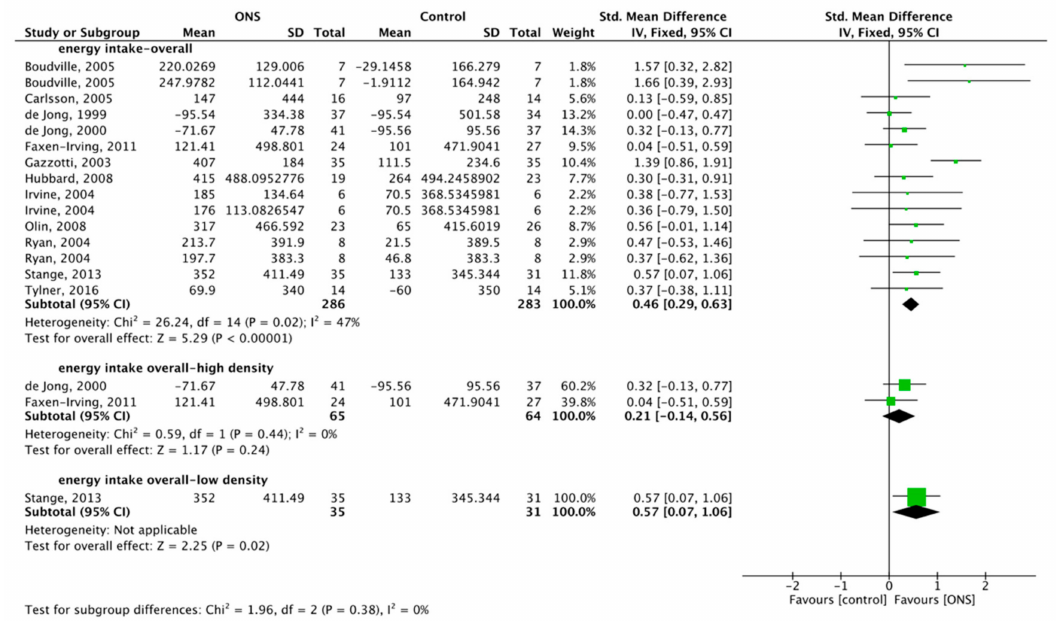
Figure 6. Forest plot comparing the effect of ONS on overall intake, and subgroup analysis.